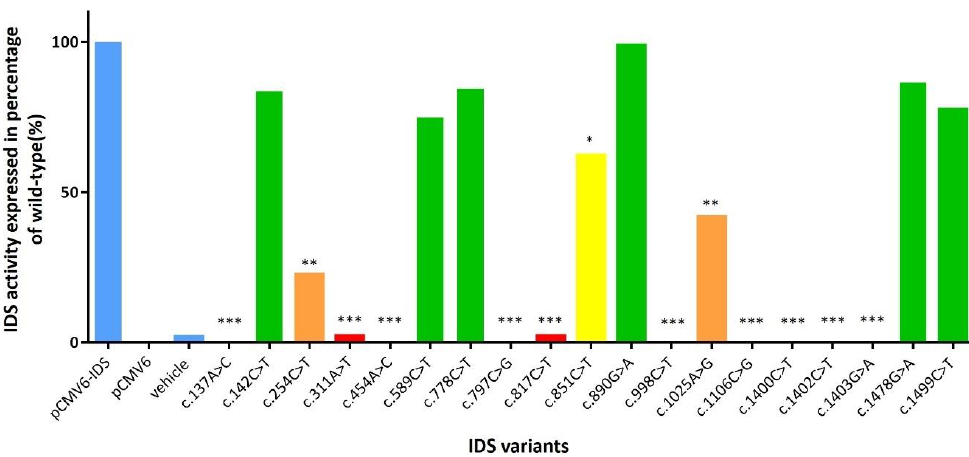
Figure 4. The percentages of IDS activity expressed in transfected COS-7 cells of individual novel missense mutations ( n = 17), and previously reported missense mutation ( n = 2). A p -value < 0.05 was considered to be statistically significant (*); p -value < 0.01 was considered to be highly significant (**); and a p -value < 0.001 was considered to be extremely significant (***).